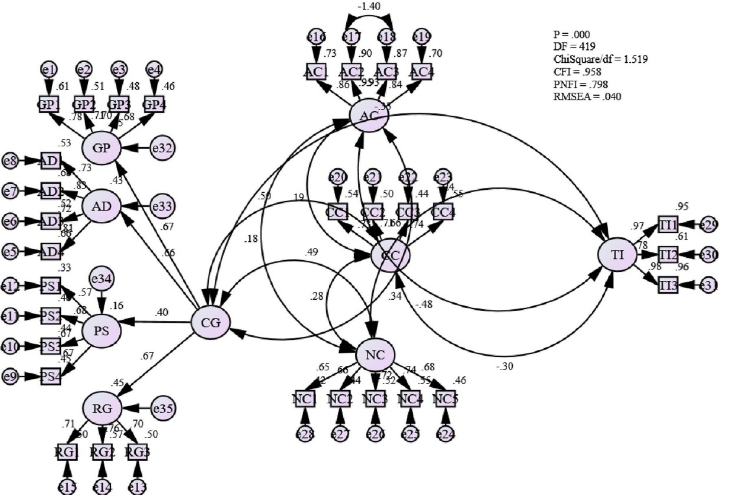
Fig 7. Measurement model for all factors.